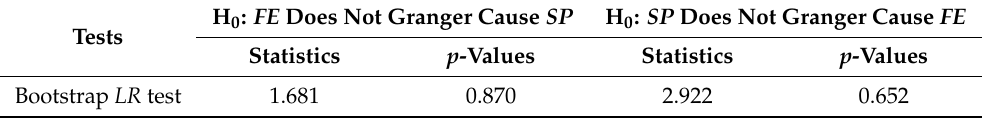
Table 2. Full-sample Granger causality tests.